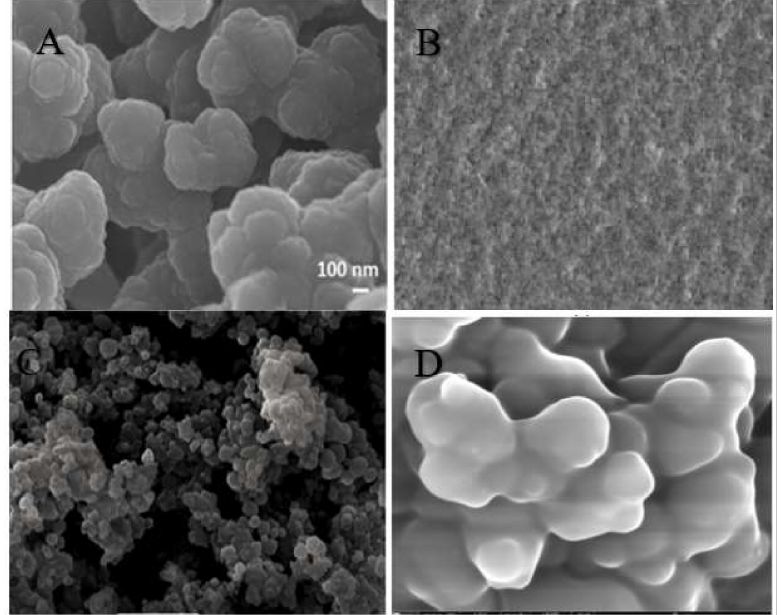
Figure 3. Scanning electron micrographs images of MIP; ( A ): bulk polymerization [58], ( B ): in situ polymerization [59]], (C): precipitation polymerization [60], ( D ): suspension polymerization